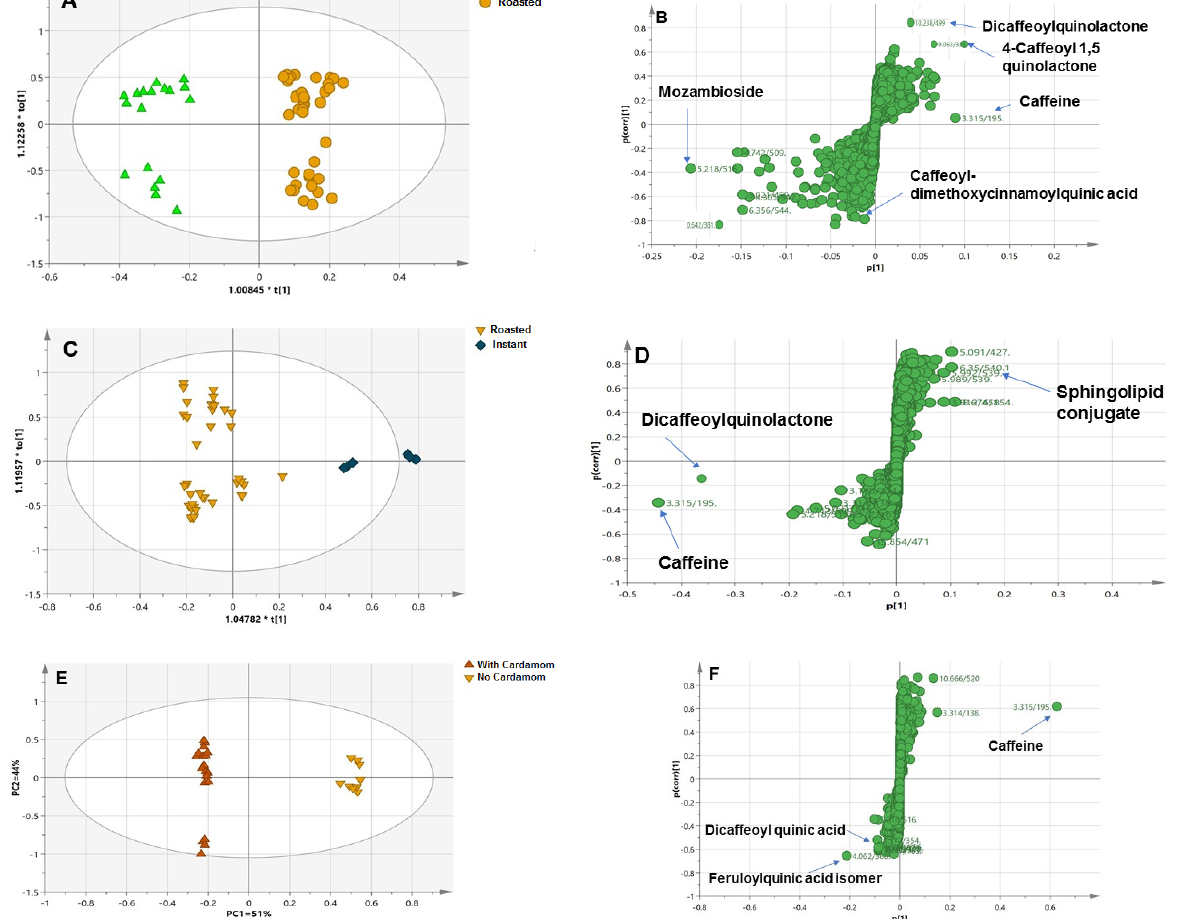
Figure 2. ( A ) OPLS-DA score plot based UPLC–MS analysis exploring green versus roasted coffee seeds. ( B ) OPLS-DA S-plot showing potential markers for green versus roasted coffee seeds. ( C ) OPLS- DA score plot for roasted versus instant samples. ( D ) OPLS-DA S-plot for roasted versus instant samples. ( E ) OPLS-DA score plot for plain versus blended coffee with cardamom samples. ( F ) OPLS- DA S-plot for plain versus blended coffee with cardamom samples. OPLS-DA S-plot models show covariance p [1] against the correlation p(cor) [1] for the variables of the discriminating components of the OPLS-DA models. Selected variables are highlighted in the S-plot and discussed in the